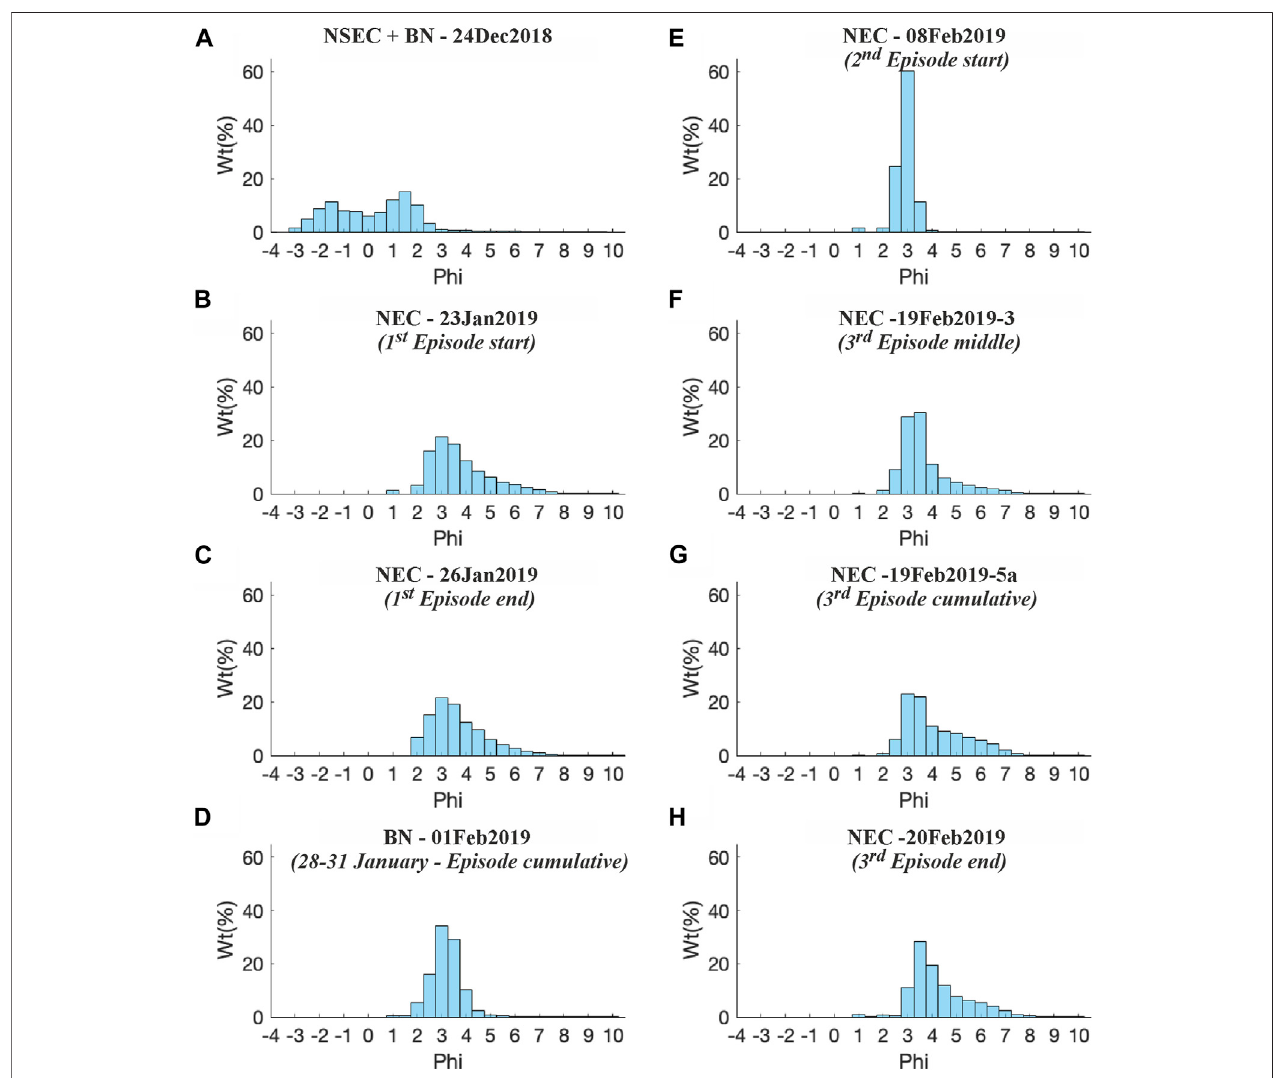
FIGURE 2 | Grain size distribution of samples related to the December 2018 activity (A) and to the January – February 2019 eruptive cycle from Northeast Crater (B,C,E – H) and BN (D) . phi = − log 2 d, with d = particle diameter in mm. Horizontal axis is 0.5 phi intervals.